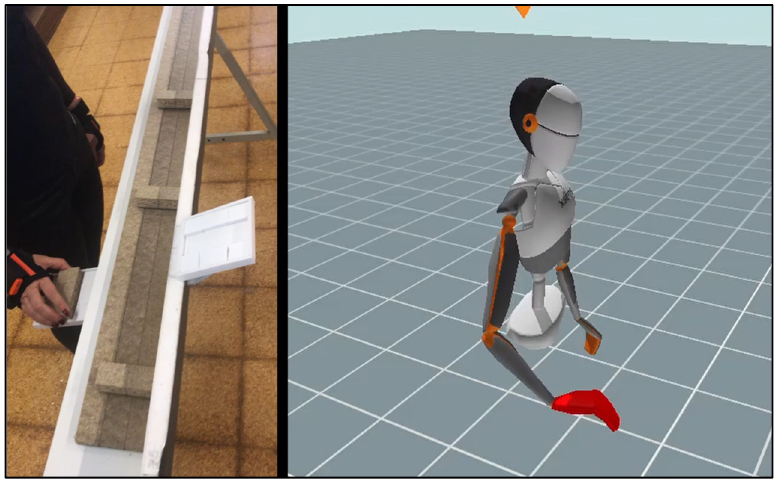
Figure 10. Participant simulating the tasks and the corresponding XSens ® output.